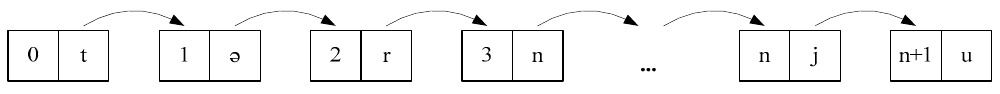
Figure 5. An example of the used data list structure.